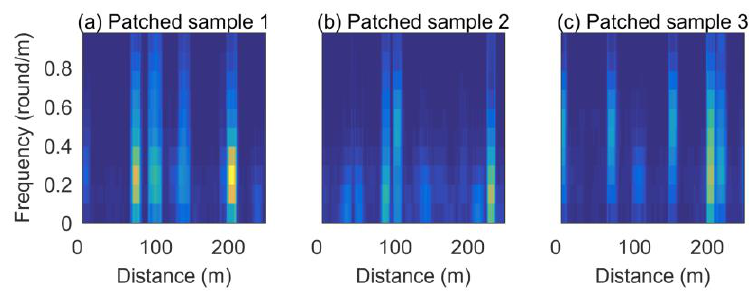
Figure 17. Spectrogram at three positions of test vehicles.